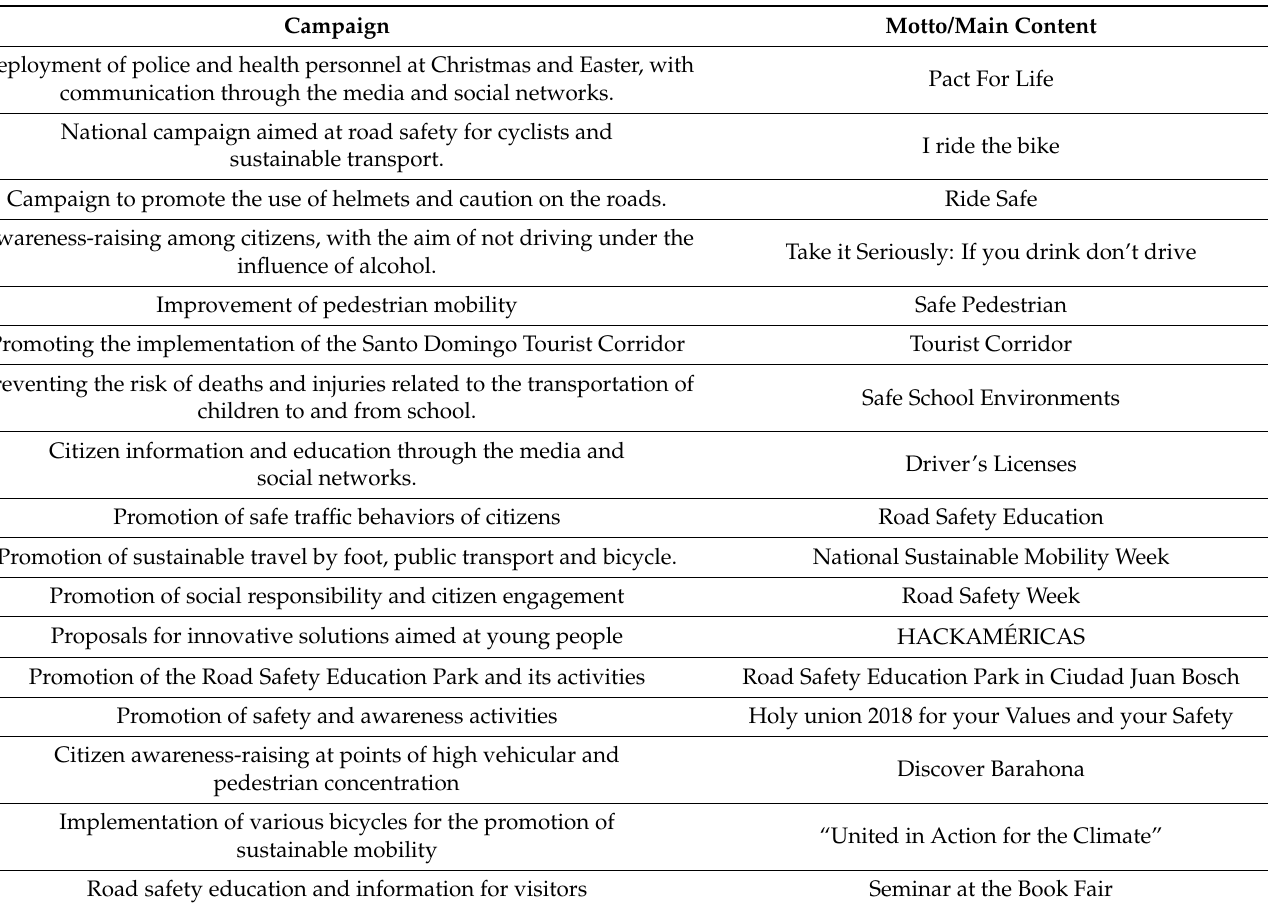
Pact For Life I ride the bike